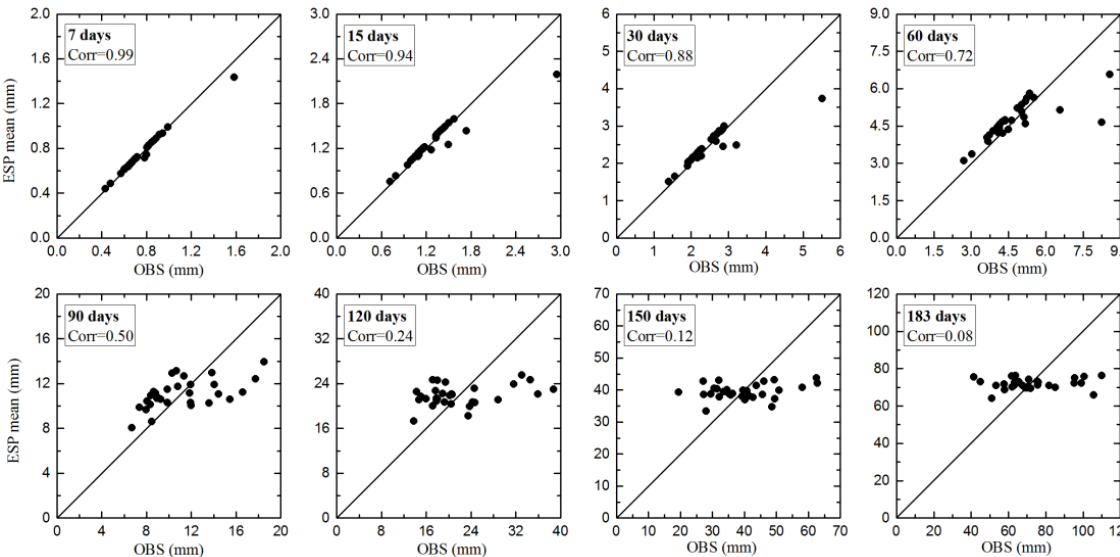
Fig. 4. Evaluation of the ESP approach for different forecast windows. The initial forecast date is 1st February.